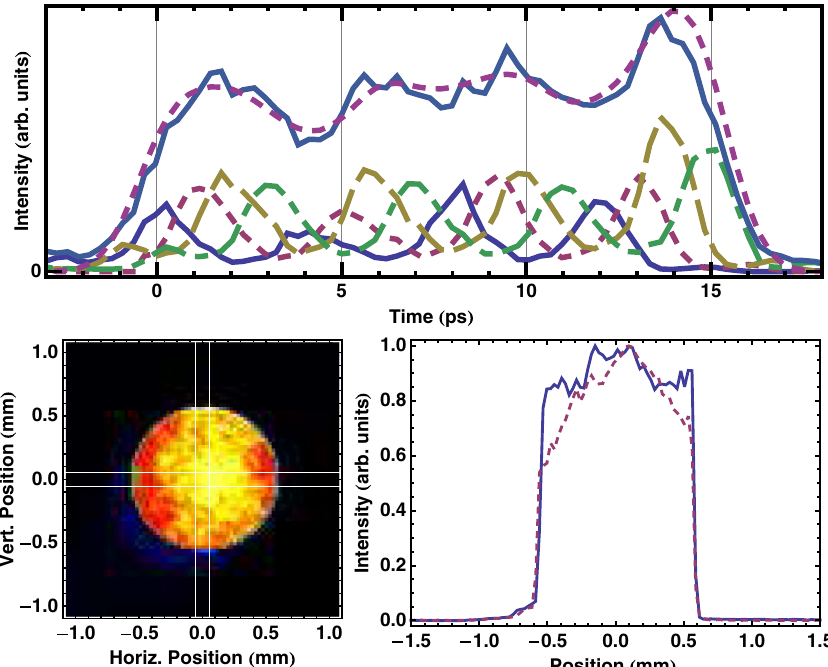
FIG. 4. (Color) Top: Cross correlation of PDL stacked UV pulse with residual IR. The bottom traces show the 16 individual pulses, and the upper traces show the sum of the cross correlations (solid curve) and the expected shape based on individually measured pulse energies (dashed curve) (see text). Bottom: The apertured PDL profile (left), and averaged lineouts within the boxed regions (right— solid: vertical, dashed: